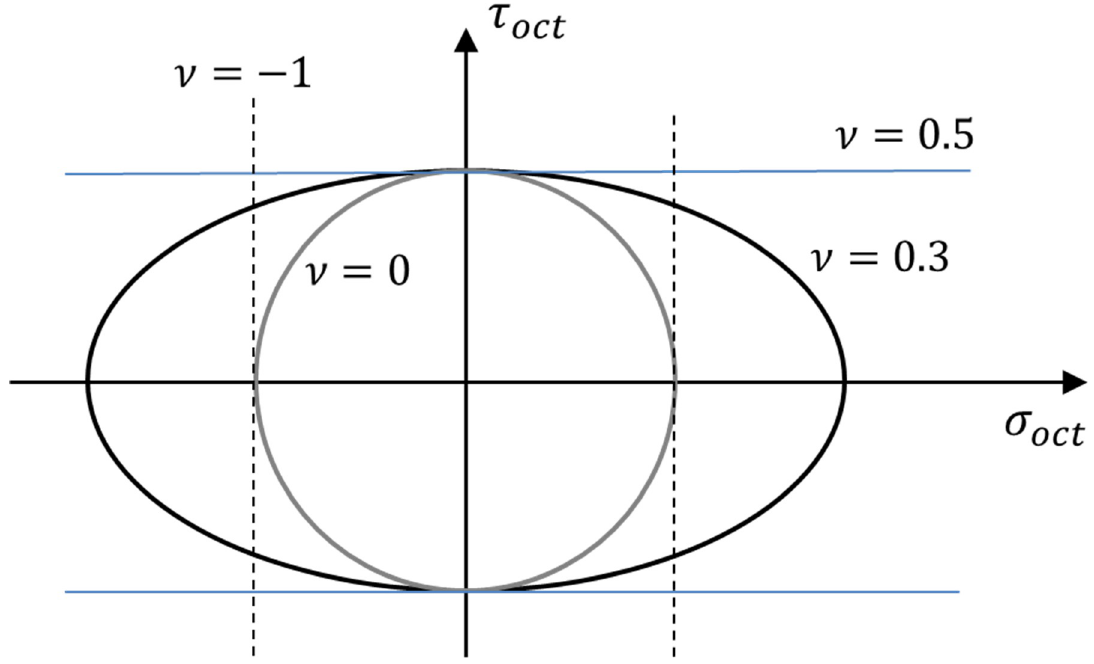
Fig 2. Linear elastic potentials for different Poisson’s ratios in octahedral stress plot.